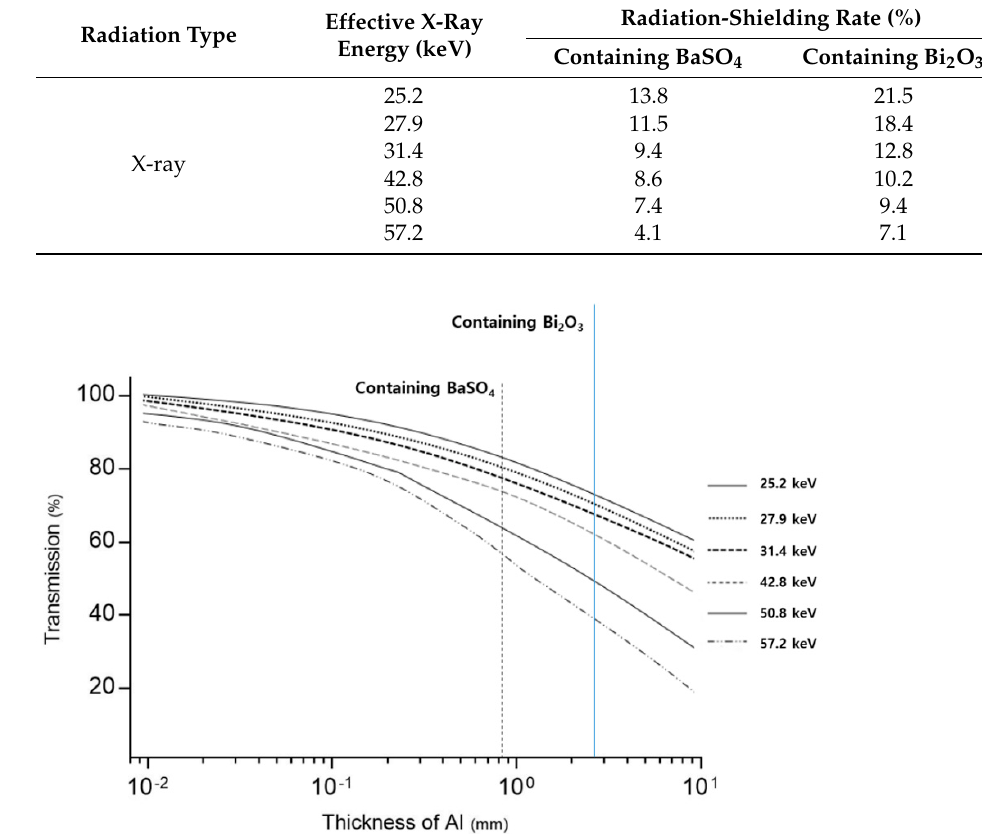
Figure 7. Radiation transmittance according to Al